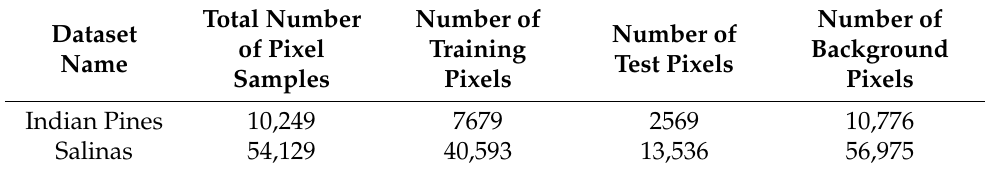
Table 2. Details of training and testing samples per band for the data sets. Table 3. Selected Parameters for CNN Model for two data sets.